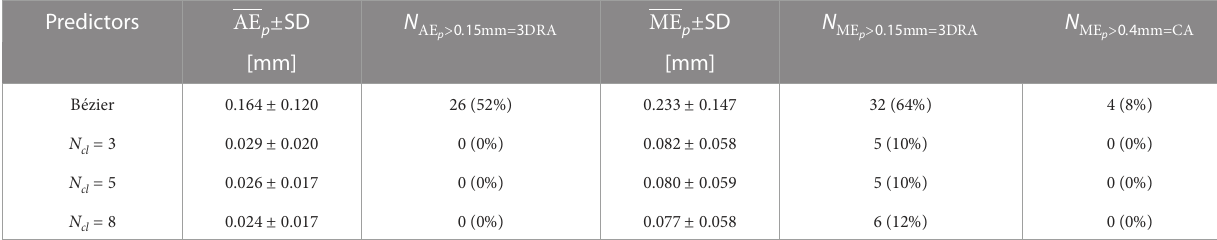
TABLE4 AnalysisofML-basedROMperformancecomparingtheBéziercurveparameters ( μ B ) andthecenterlinepointsparameters ( μ cl ) asGPRpredictors.The resultsareobtainedwith L =15and N train